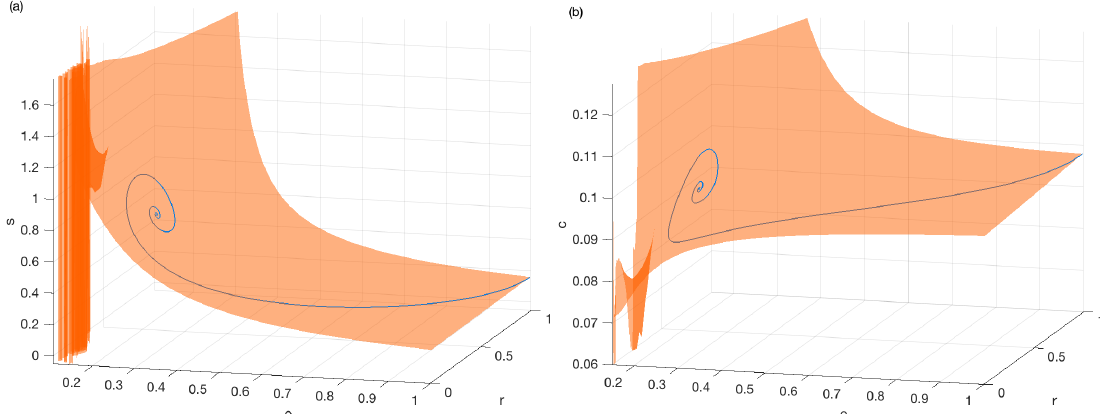
Figure 2. Computed two-dimensional slow manifold of the ODE model (11) for the same parameters as Figure 1. A trajectory started from a corner of the computed surface is shown to demonstrate the approximate invariance of the surface. The manifold was computed by taking four iterates of Equation (17) starting from the initial function (14). ( a ) s ( r , e ) ; ( b ) c ( r , e )